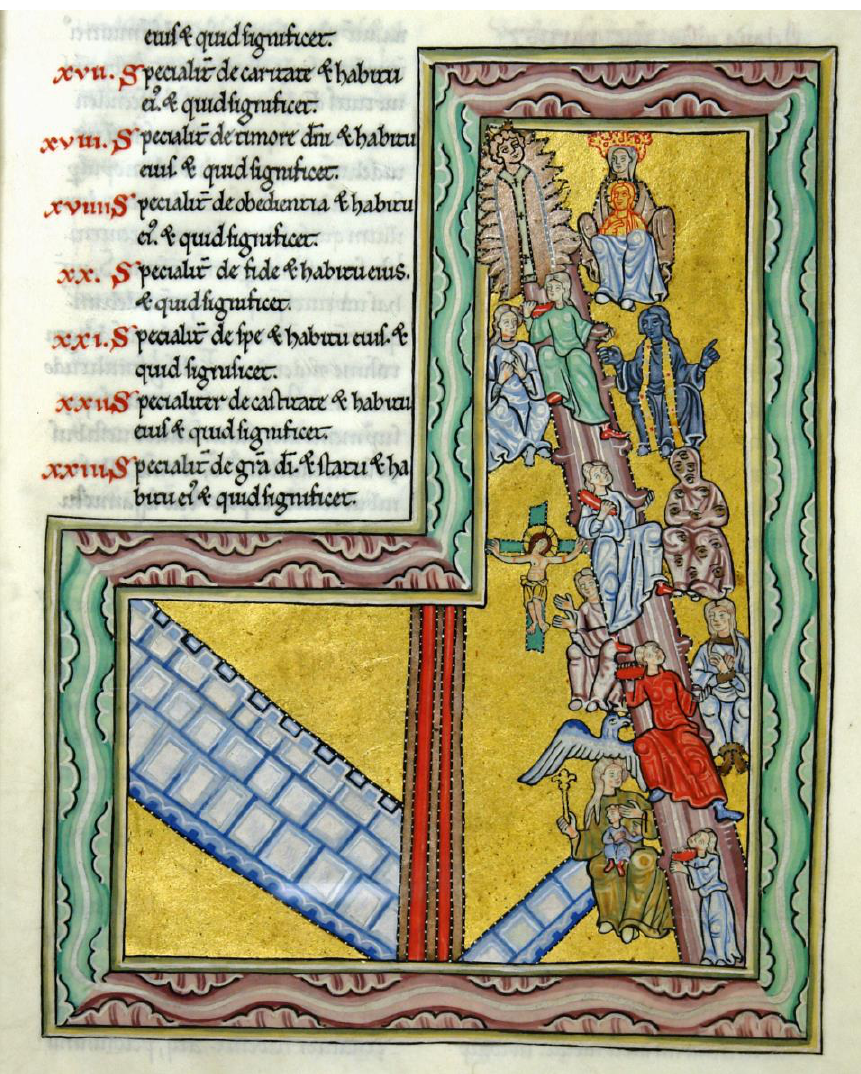
Figure 6. Scivias 3.8: The Pillar of the Savior’s Humanity. Rüdesheim/Eibingen, Benediktinerin- nenabtei St. Hildegard, MS 1, fol. 178r. By permission of the nuns of the Benediktinerinnenabtei St.